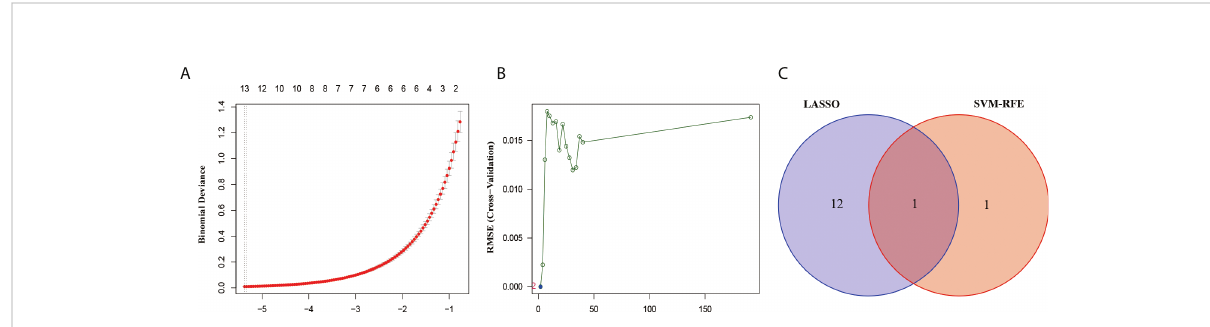
FIGURE 2 Screened the most relevant genes for LUAD-BM. (A) Ten-time cross-validation for DEGs in the LASSO. (B) The Root Mean Square Error (RSME) curve of DEGs in SVM-REF. (C) The intersection genes selection between LASSO and SVM-RFE